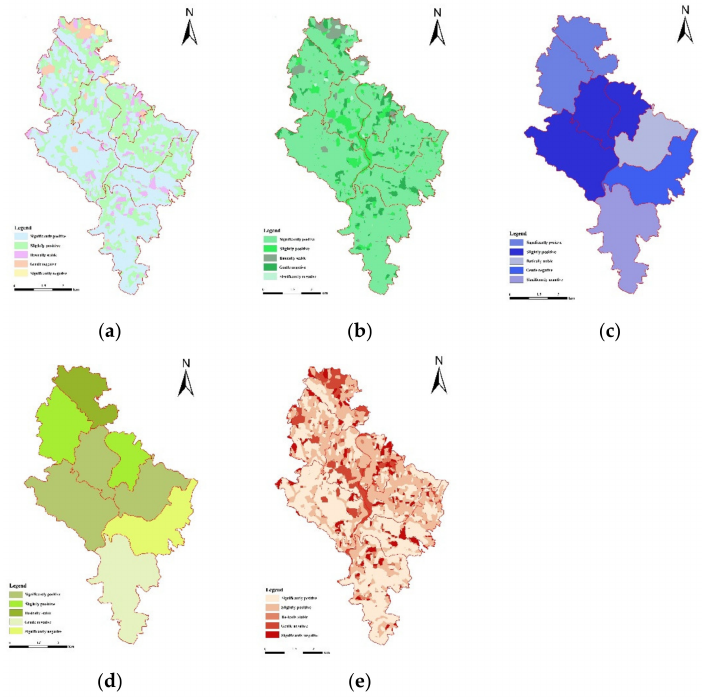
Figure 9. Evaluation results of the ecological environmental effect trend of rural land use from 2019 to 2030 (ecological orientation, EO). ( a ) Resource effect trend in 2019–2030; ( b ) environmental effect type in 2019–2030; ( c ) social effect type in 2019–2030; ( d ) economic effect trend in 2019–2030; ( e ) ecological environmental effect trend in